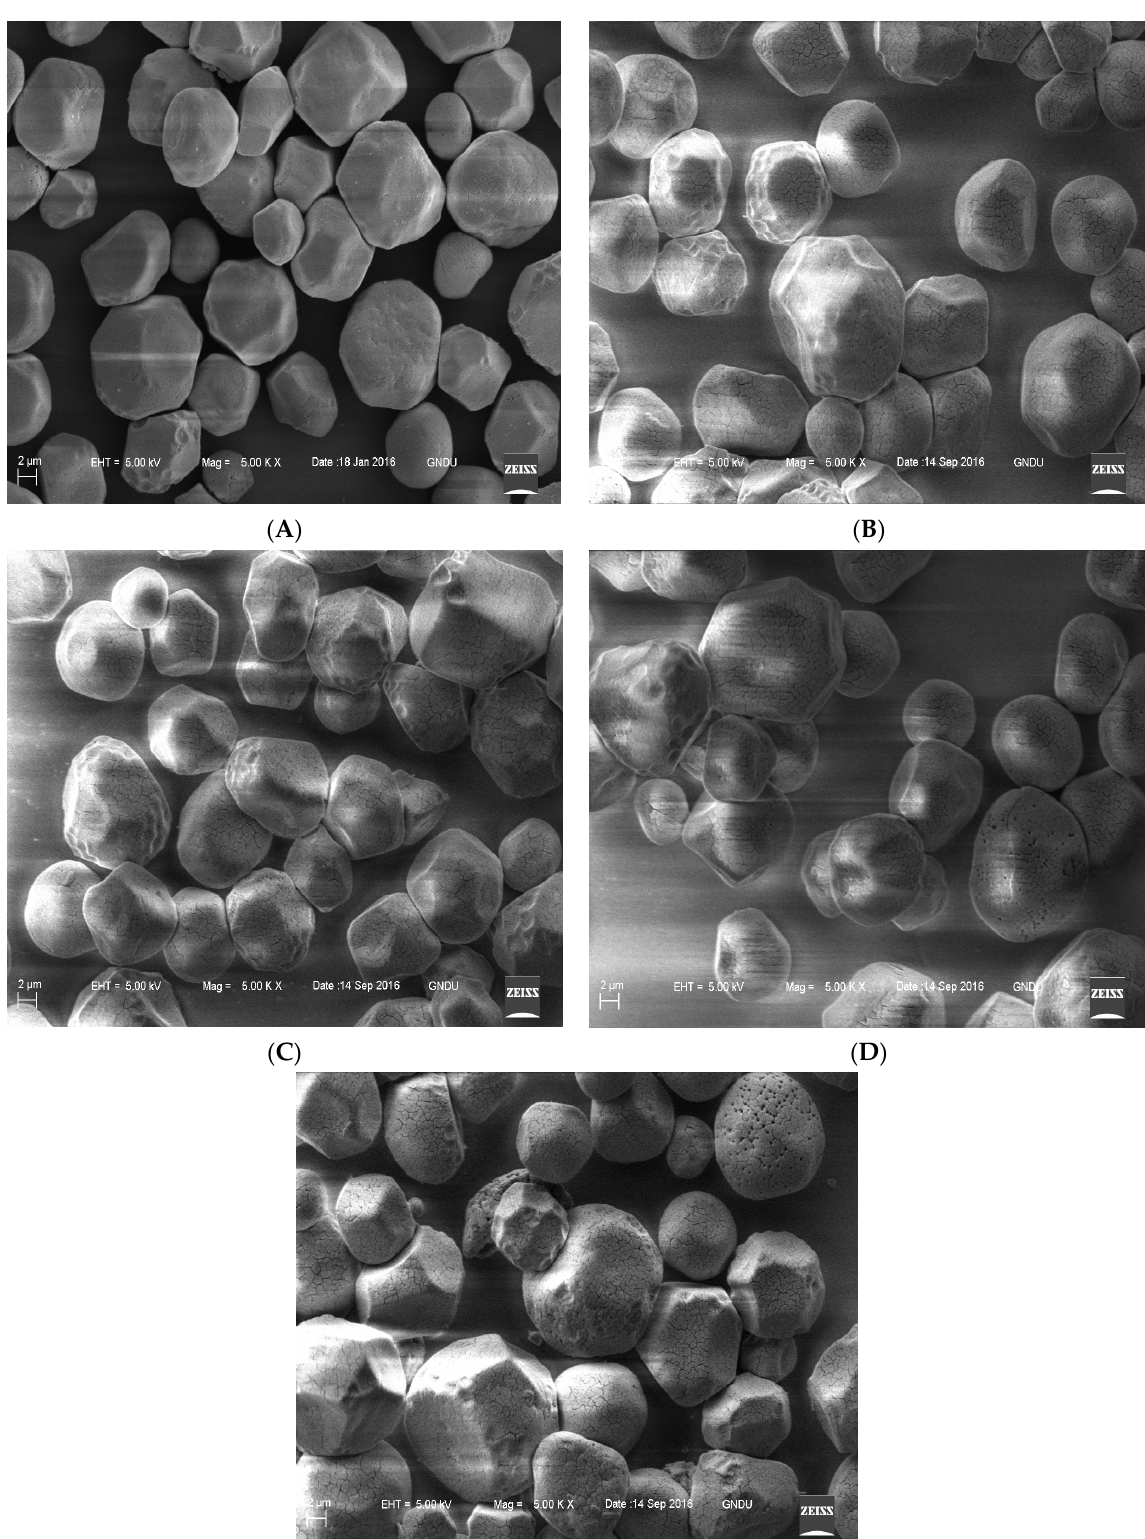
Figure 3. Morphological properties of native and modified starches. ( A )-Native; ( B ) (Cross-linking at 0.1%); ( C ) (Cross- linking at 0.3%); ( D ) (Cross-linking at 0.5%); ( E ) (Cross-linking at 0.8%).